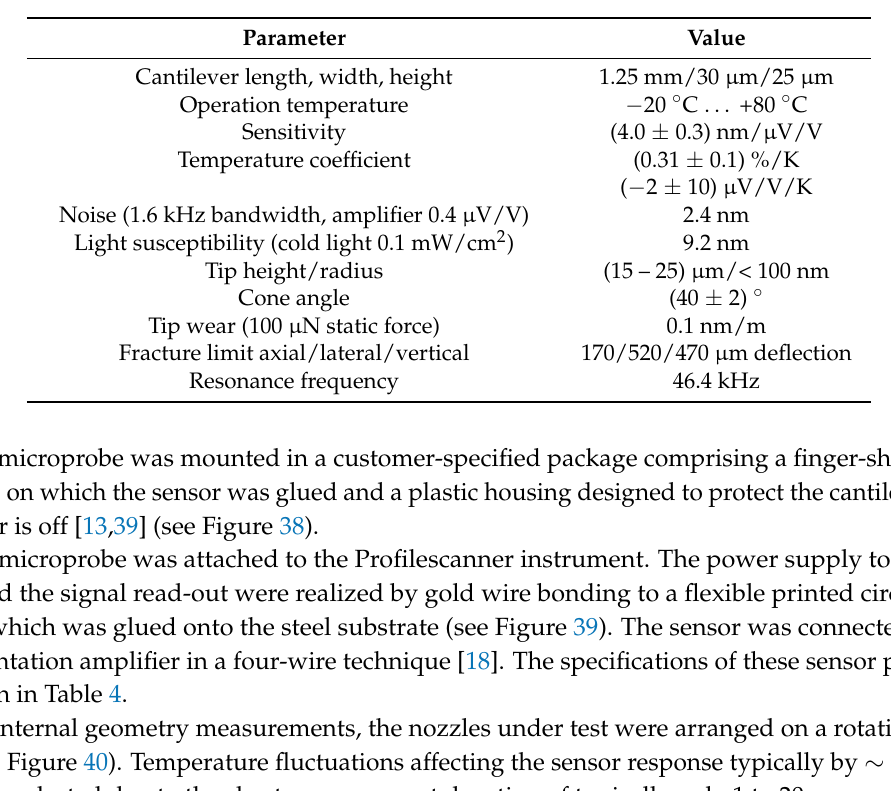
Figure 37. The microprobe in front of a nozzle with 800 µ m diameter. The nozzle opening itself is not visible. The cantilever is 7.5 mm long. It consists of two cantilevers that are glued together.